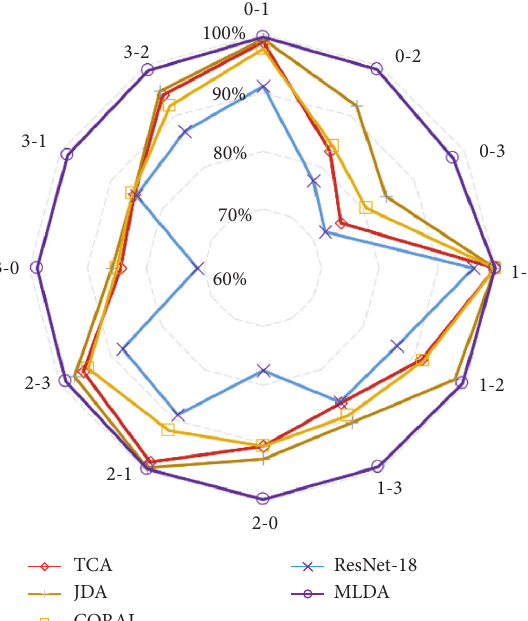
Figure 9: Radar diagram of the diagnostic results of different models.